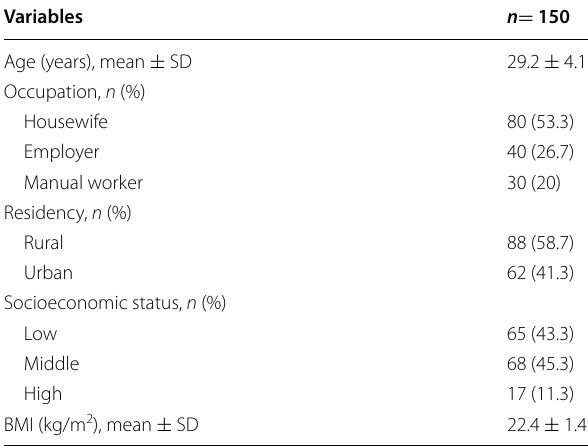
Table 1 Baseline characteristics of the studied